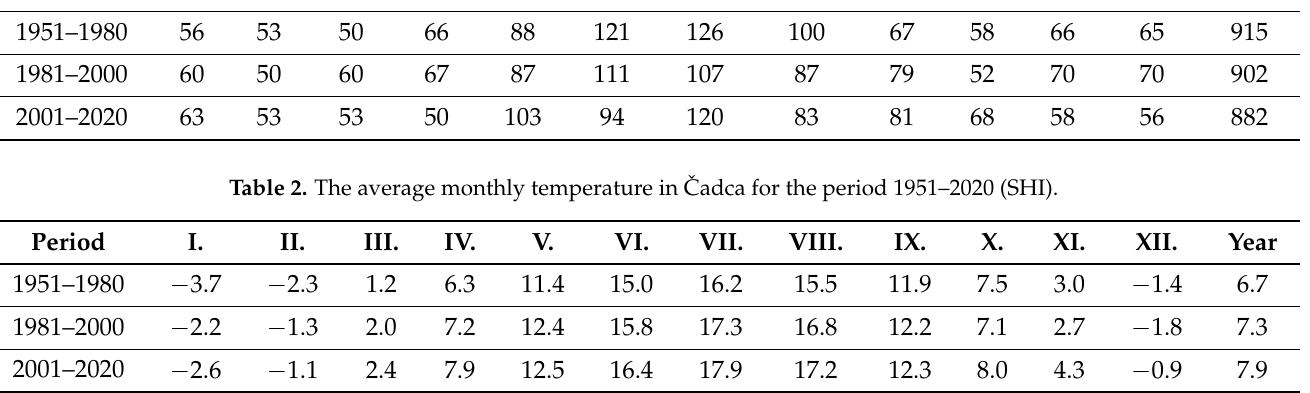
Table 1. The average monthly total precipitation in ˇCadca for the period 1951–2020 (SHI). Period I.